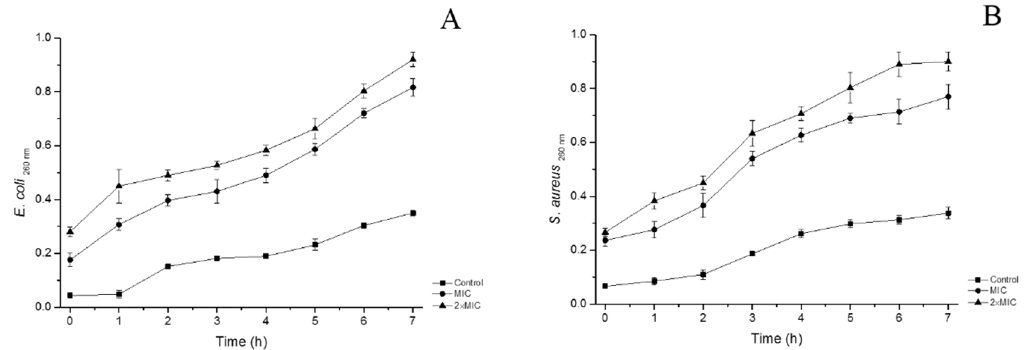
Figure 4. E ff ects of FCEO on the integrity of cell membrane of E. coli and S. aureus . ( A ): E. coli ; ( B ): S. aureus .